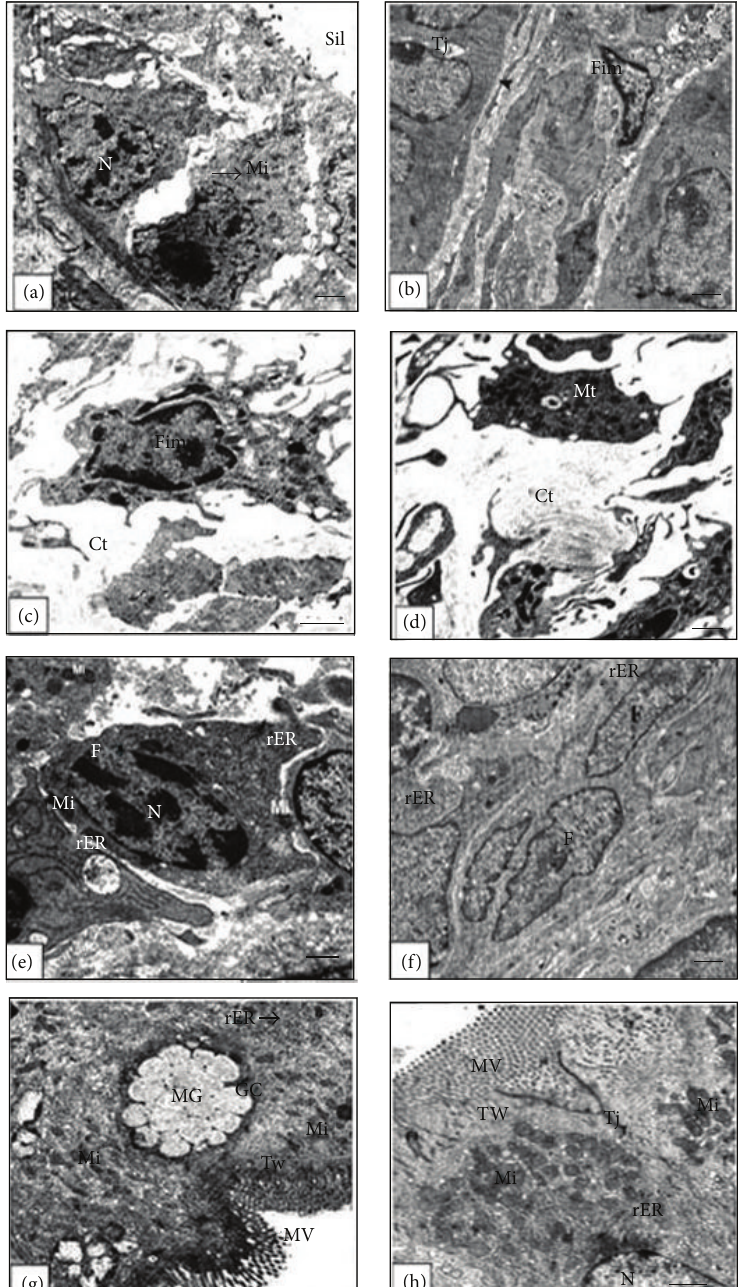
Figure 1: Electron micrographs of the anterior portion of the small intestine of the larval stage 42 ((a)–(d)) and the premetamorphic stage 50 ((e)–(h))showing thefollowing. (a)and (b):epithelial cells contact tothebasal lamina (arrowhead). (c): animmaturefibroblast-likecell (Fim) with large nuclei and poorly developed cell organelles. (d): a mitotic cell (Mt) in the connective tissue. (e): a fibroblast with well-developed rough endoplasmic reticulum (rER). (f): connective tissue (Ct) contains a fibroblast (F) with well-developed rER. (g): a goblet cell (GC) containing mucous granules (MG) in the apical surface of the larval epithelium. (h): supranuclear cytoplasm of two adjacent columnar cells with uniform microvilli (MV), numerous mitochondria (Mi), and vesiculated rough endoplasmic reticulum (rER) beneath a well-developed terminal web (TW). The lateral junctional complex joining neighboring cells is visible. Scale bar = 1 𝜇